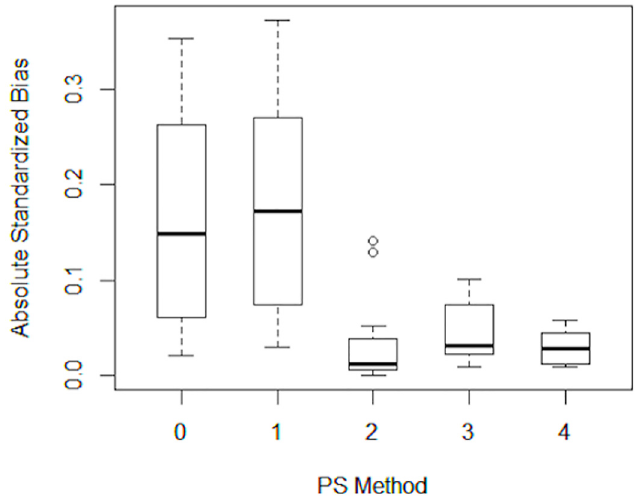
Fig 1. Boxplots of Absolute Standardized Biases for the Covariates in the Propensity Score Model. Methods. 0-original sample, no matching or weighting; 1- greedy 1:1 nearest neighbor matching, 2- greedy 1:1 nearest neighbor matching with exact match on race and caliper of 0.2, 3- full matching (constrained), 4- inverse probability weighting